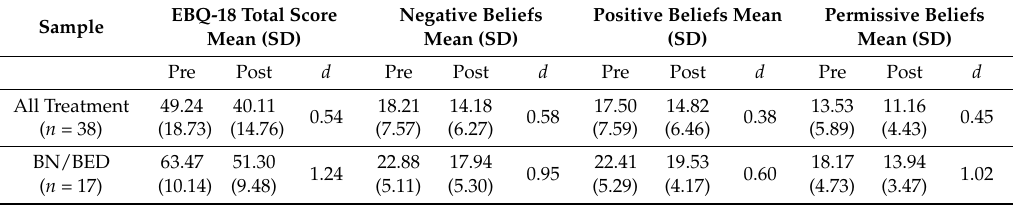
Table 6. Means, SDs and Cohen’s d effect sizes for EBQ-18 scores at pre and post